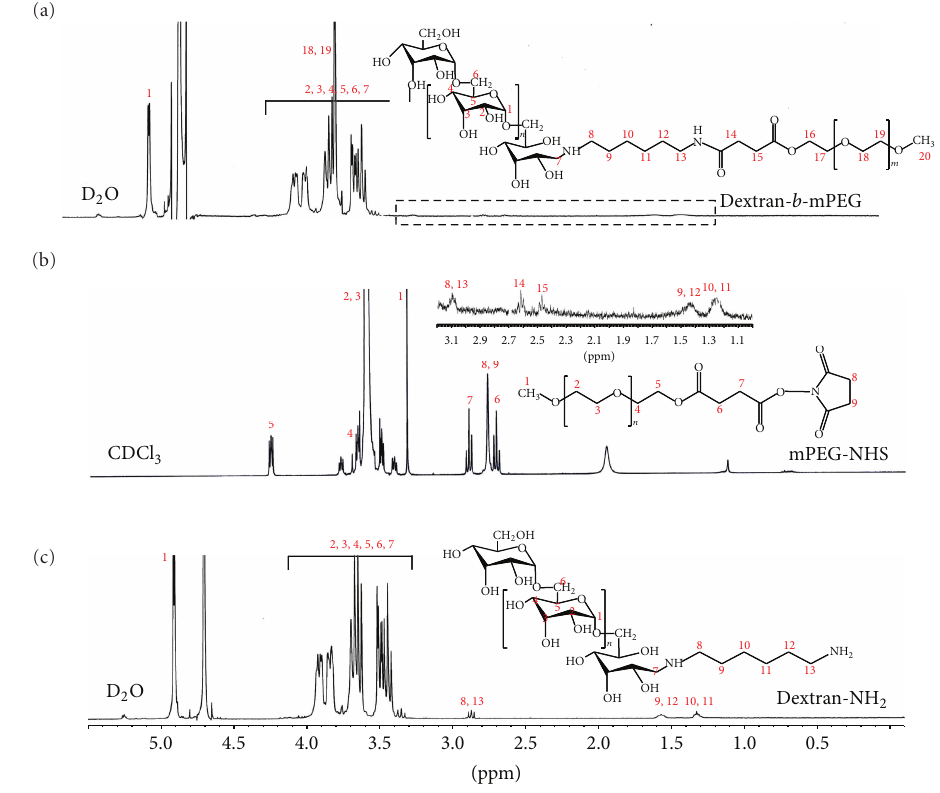
Figure 4: 1 H spectra of dextran-NH 2 in D 2 O (a), MPEG-NHS in CDCl 3 (b), and DexPEG block copolymer in D 2 O (c).